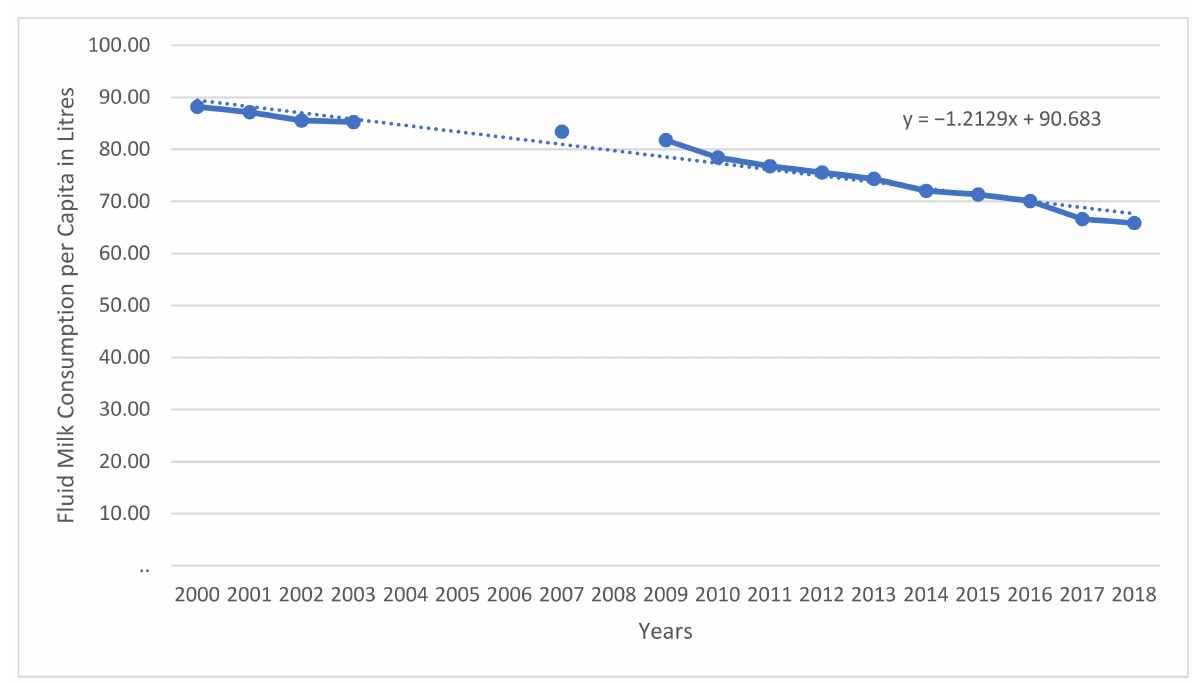
Figure 1. Annual Total Fluid Milk Consumption in Liters per Capita Canada (2008 to 2018 where Data Available). Source: Statistics Canada; Compiled by Agriculture and Agri-Food Canada, Animal Industry Division, Market Information